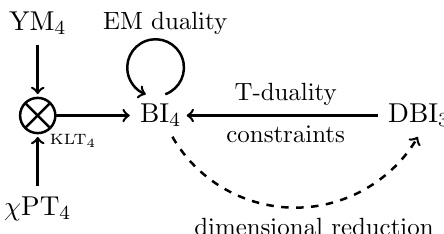
Figure 1 . Some key-properties of BI amplitudes at tree-level, in particular the double-copy con- struction and 4d electromagnetic duality. The idea behind the T-duality constraint [5] is that when dimensionally reduced along one direction, a linear combination of the photon polarizations become a scalar modulus of the compacti(cid:12)ed direction,. i.e. it is the Goldstone mode of the spontaneously broken translational symmetry and as such it must have enhanced O ( p 2 ) soft